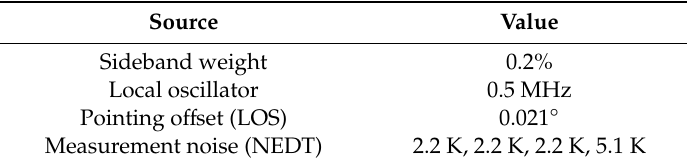
Table 3. Uncertainties assumed for instrument.